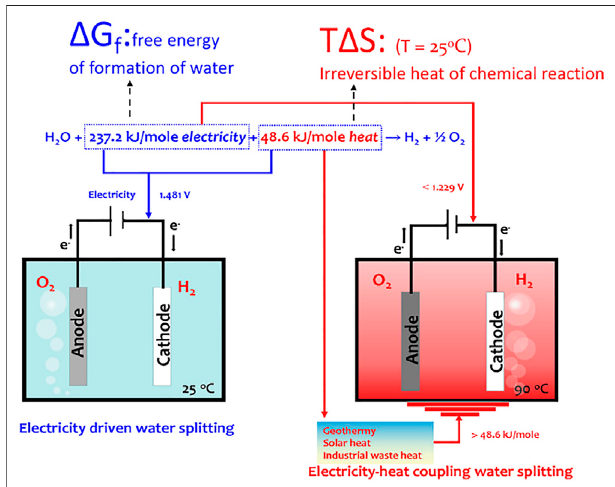
FIGURE 6 | Heat – electricity coupling electrolyzer to show the revolution in device designing guided by multi-energy coupling ideas. Reprinted with permission from Ref.12. Copyright © 2022, American Chemical